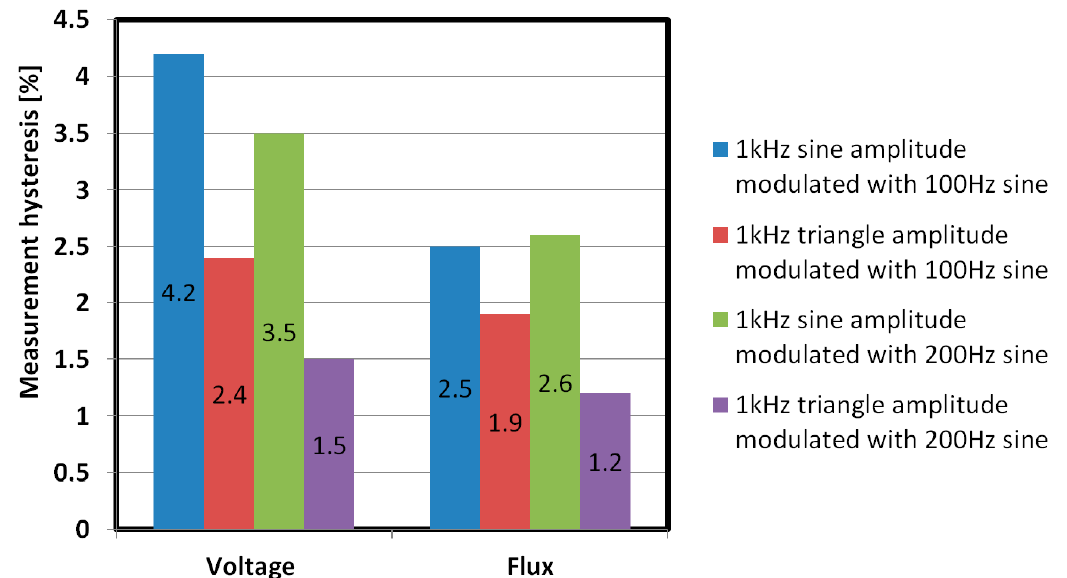
Figure 16. Measurement hysteresis errors for voltage and magnetic flux measurements with an AM modulated magnetizing current supply.